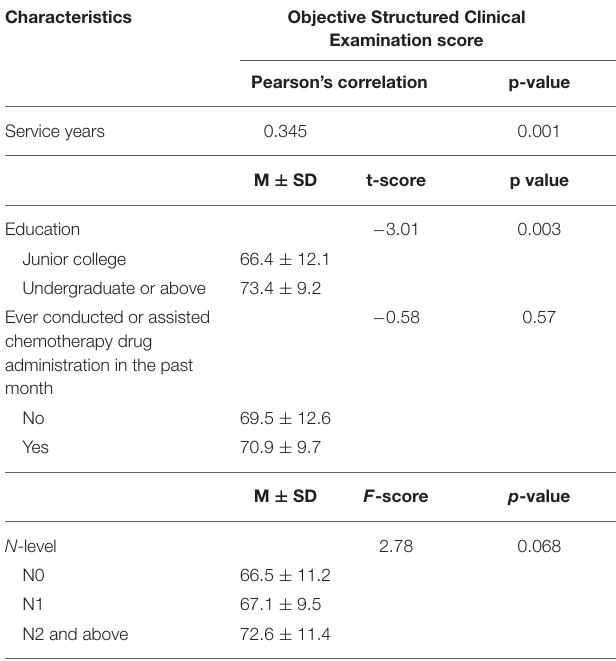
TABLE 2 | OSCE score between VR and control groups ( N = 83) in demographic variables and experience of chemotherapy administration. Characteristics